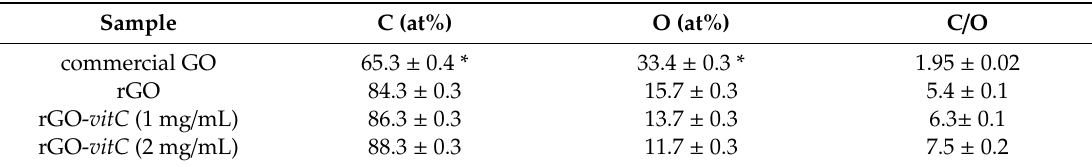
Table 1. Atomic concentration values for C and O elements as derived from semiquantitative analysis of XPS